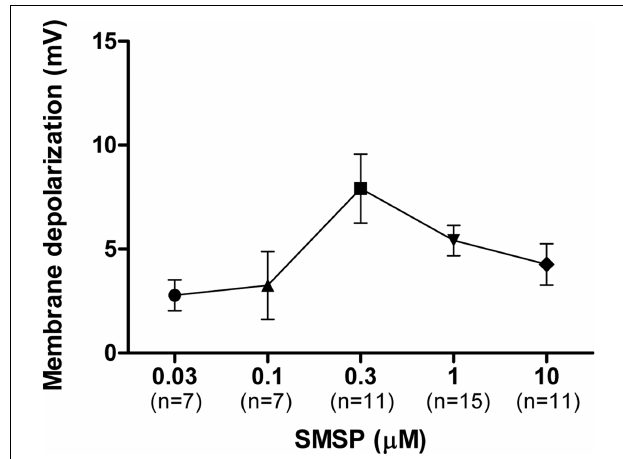
FIGURE 2 | Dose-dependent effects of SM-SP. The magnitude of membrane depolarization of globus pallidus neurons was dependent of the concentration of SM-SP. n indicates the number of cells studied. Only one dose of SM-SP was tested on one